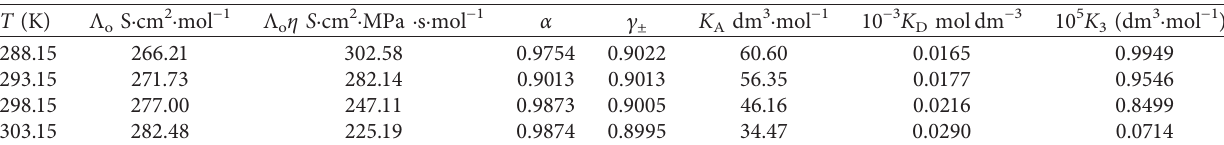
Table 5: Different association parameters (limiting molar conductance ( Λ 0 ), Fuoss–Shedlovsky parameter S ( z ) , degree of dissociation ( α ), activity coefficient ( Ɣ ± ), association constant ( K A ), dissociation constant ( K D ), triple ion association constant ( K 3 )) for nano-CuCl 2 · 2H 2 O in distillate H 2 O at 288.15, 293.15, 298.15, and 303.15 K in the absence of